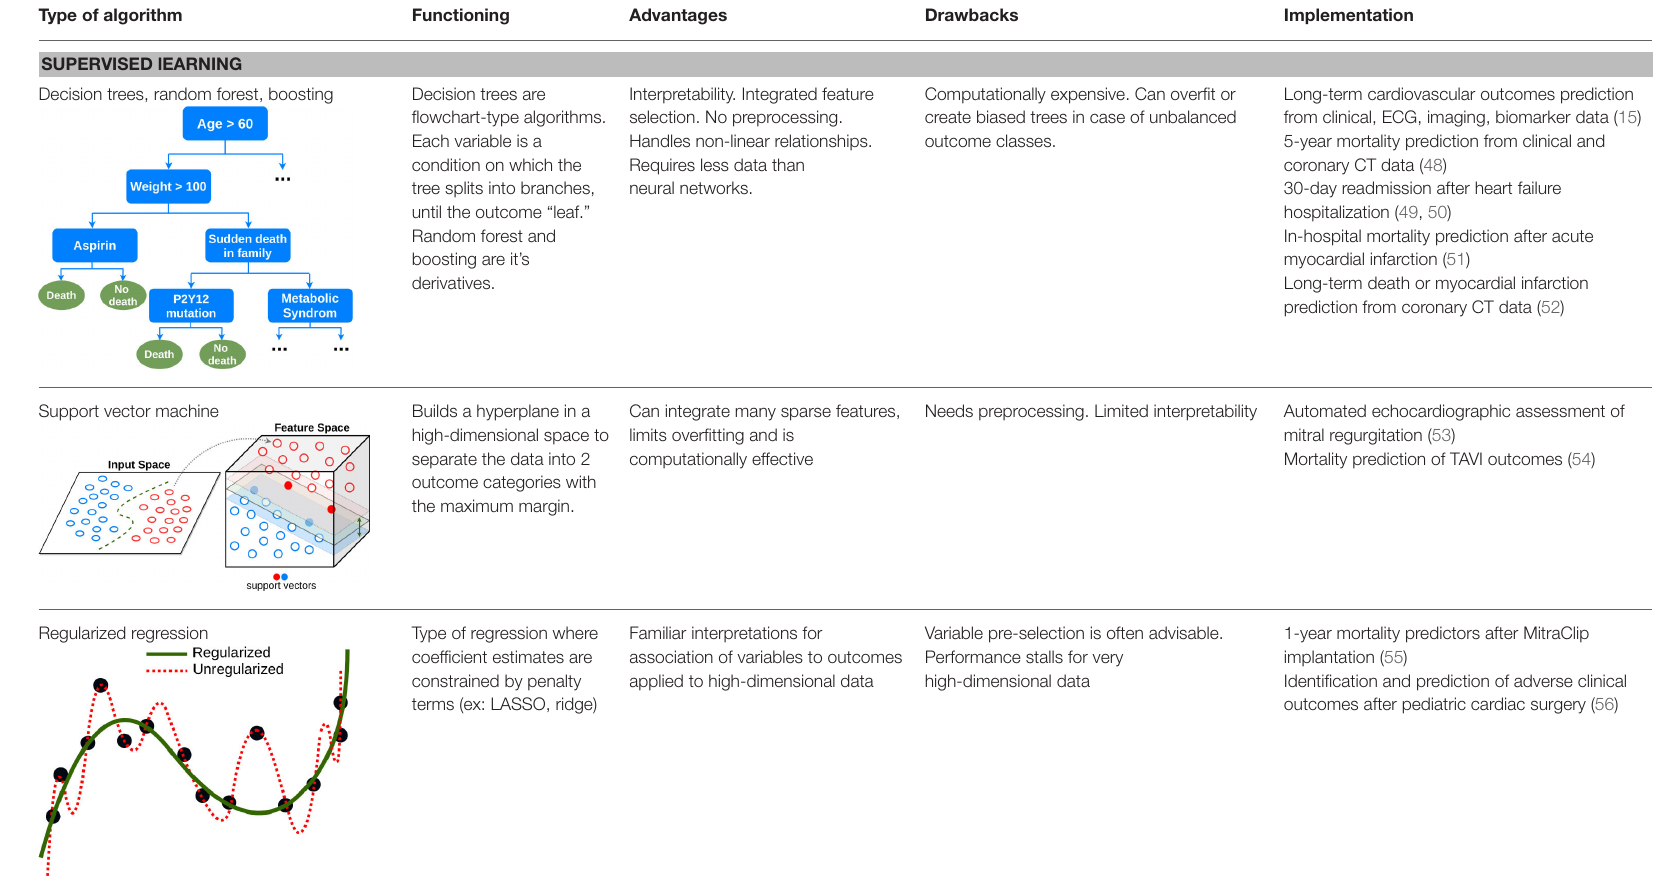
TABLE 2 | Algorithmic overview with prominent examples of implementation in cardiology. Type of